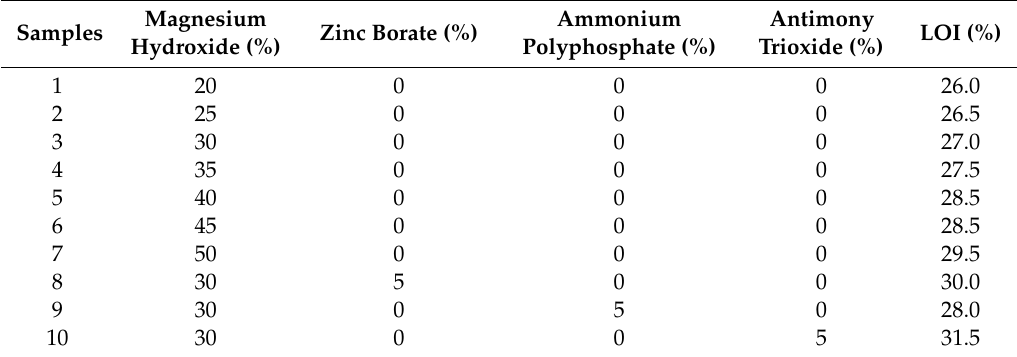
Table 2. Flame retardant properties of kapok fiber